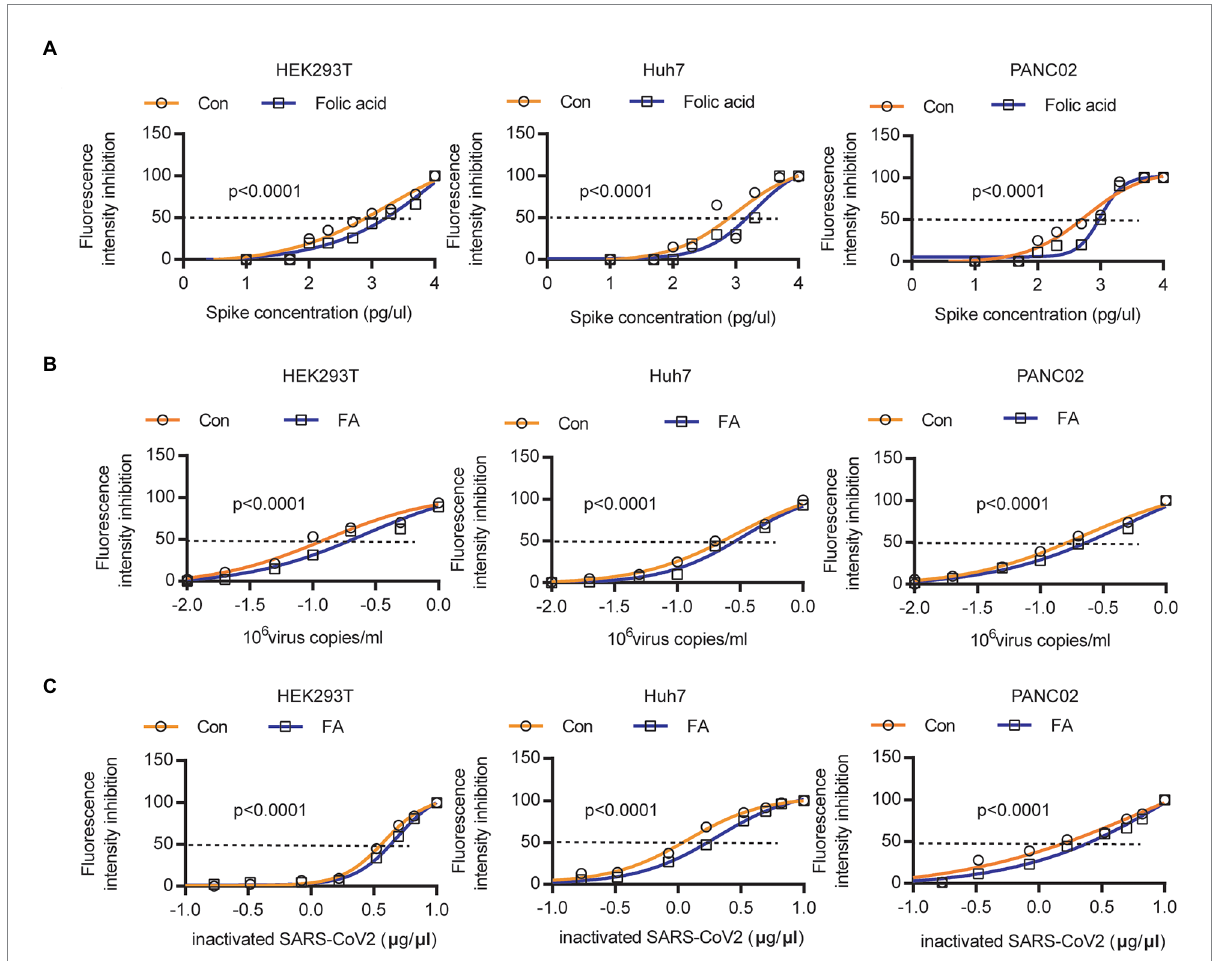
FIGURE 3 Folic acid reduced the 50% Spike protein or SARS-CoV-2 binding to host cells. (A) The 50% effective concentration of Spike protein was increased by 61.6, 98.2 and 72.1% in HEK293T/PANC02/Huh7 cells. (B) The 50% effective concentration of pseudoviruses was increased by 93.2, 15.3 and 93.1% in HEK293T/PANC02/Huh7 cells. (C) The 50% effective concentration of inactivated authentic SARS-CoV-2 was increased by 17.6, 65.3 and 70.8% in HEK293T/PANC02/Huh7